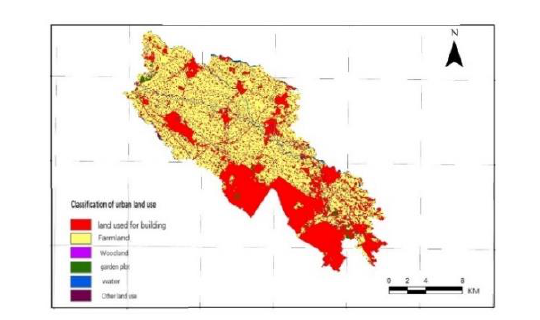
Figure 2 Classification of Land Types in 2005